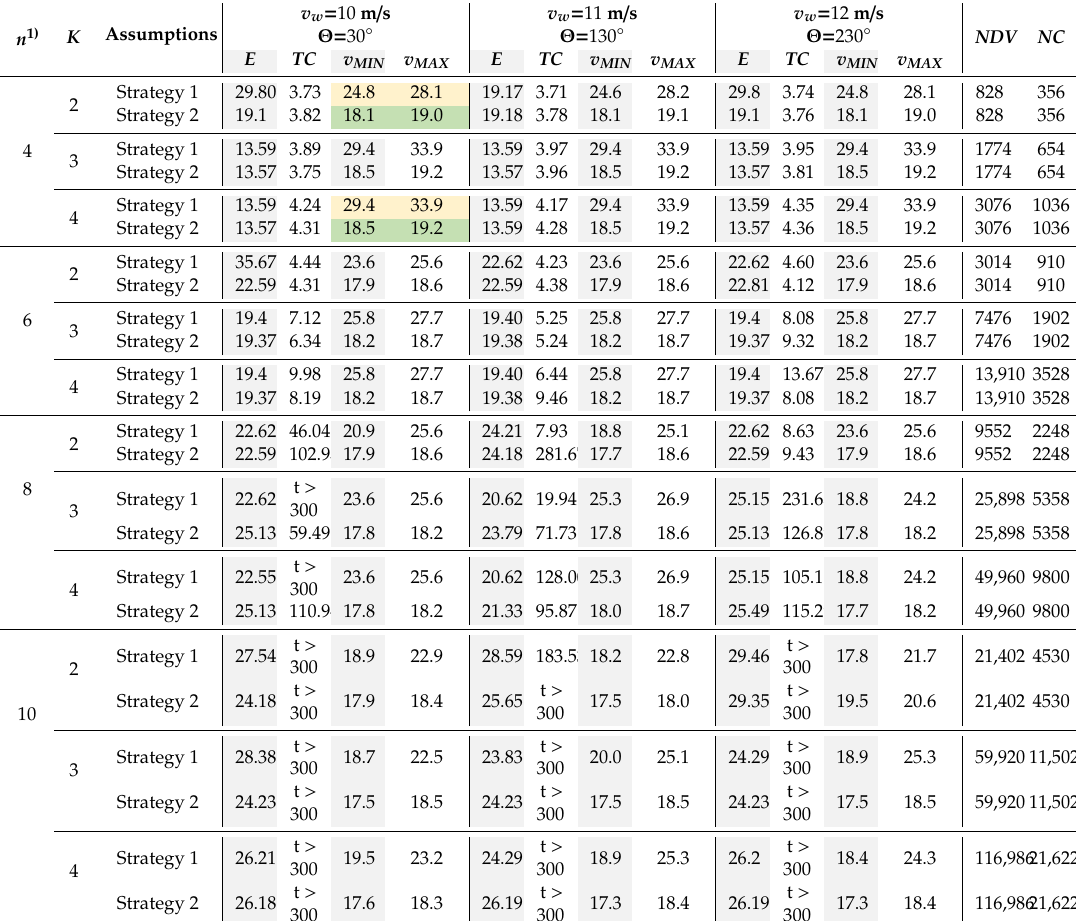
Table 2. Results of selected